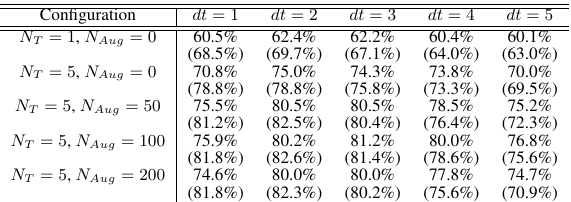
Table 2. Short-term forecasting performance of the proposed end-to-end learning scheme : we evaluate the proposed end-to-end learning framework, where we vary the number N T of past SSH fields used as inputs and the dimension N Aug of the augmented components for variable x (i.e., N Aug = 0 corresponds to a multivariate space-time field with the same dimension of the SSH sequence). As performance metrics, we compute a normalized mean square error (MSE) of the dt -day-ahead forecasting with dt from 1 to 5 for the SSH and its Figure 4. Illustration of the training of an adaptive sampling gradient norm. We let the reader to the main text for additional design for the reconstruction of SSH fields from details. irregularly-sampled data: in the first row, we report for a reference SSH field (top left), the associated OI reconstruction from nadir altimeter data (top right) along with the reconstruction issued from the proposed end-to-end learning framework. For the reported example, the trained sampling operator proposes to sample data along the main front as well the main eddies (bottom right) to complement the nadir altimeter data. As illustrated by the gradient norm fields (bottom row), the additional measurements lead to an improvement of the reconstruction of the gradient field. Quantitative results are in